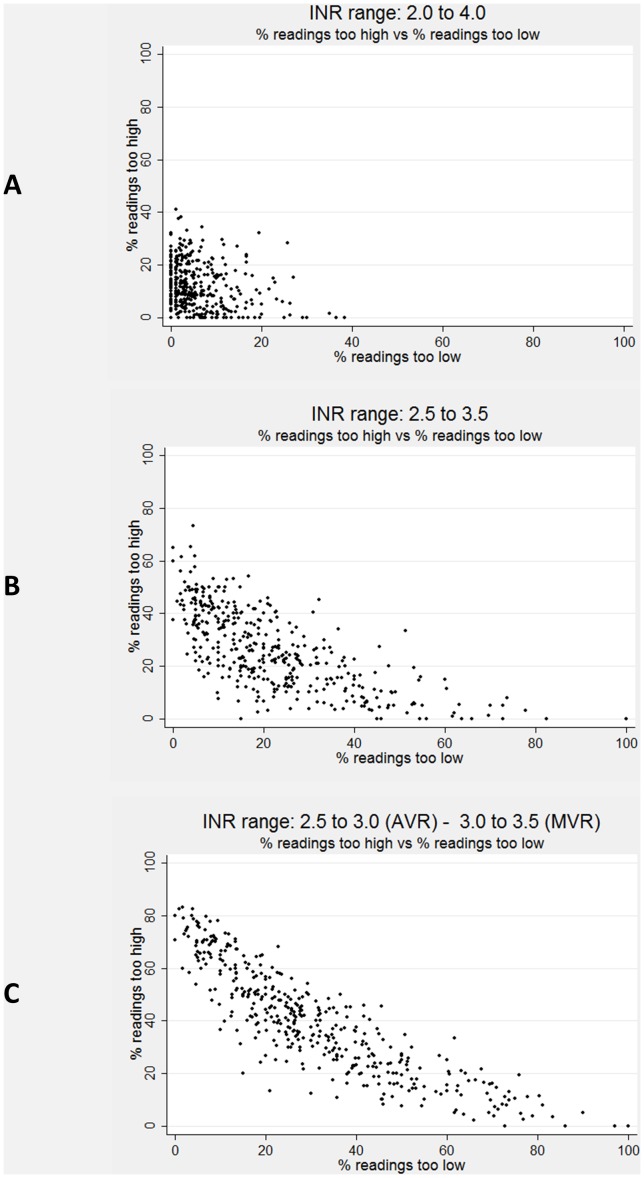
Plot of proportion of time too high and too low for target INR range I (2.0 to 4.0), INR range II (2.5 to 3.5) and INR range III (2.5 to 3.0 for the AVR and 3.0 to 3.5 for the MVR groups).